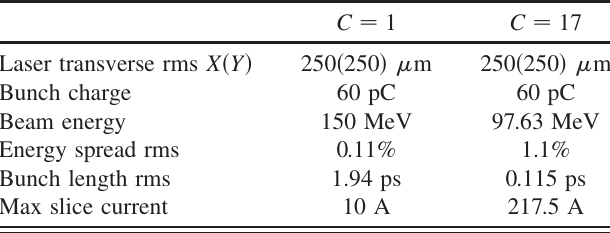
TABLE III. Comparison between uncompressed ( C ¼ 1 ) and compressed ( C ¼ 17 ) beam parameters for the 60 pC case.